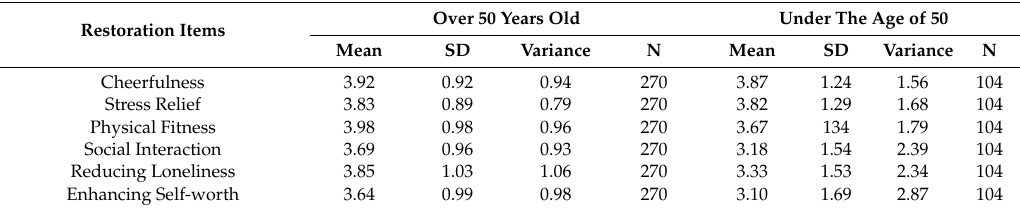
Table 4. Activity restoration effects.